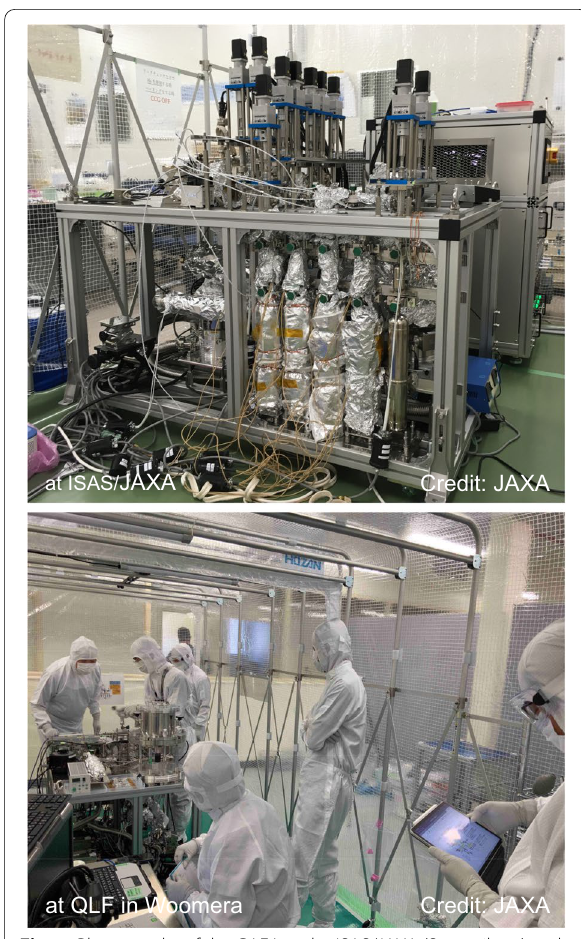
Fig. 7 Photographs of the GAEA at the ISAS/JAXA (Sagamihara) and the QLF